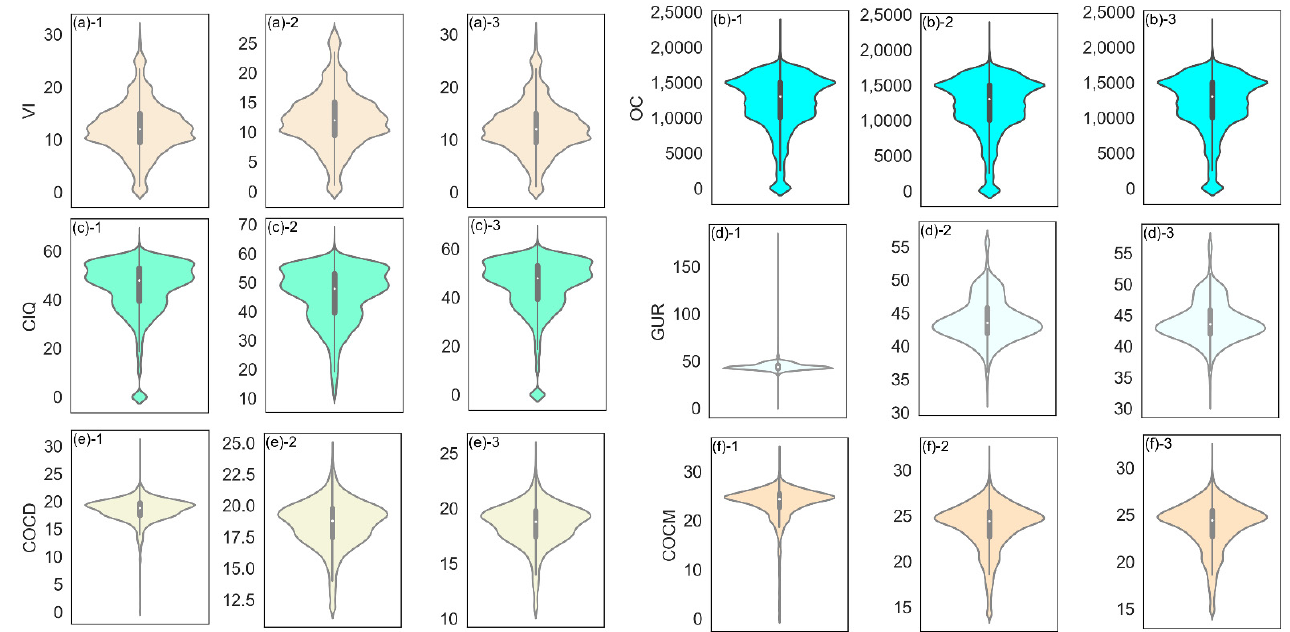
Figure 2. ( a – f ) Comparison of original data and processed data (2), i (i = 1, 2, 3) represents the data before a feature is processed, after it is processed by the box plot, and after it is processed by the 3 σ criterion, respectively.